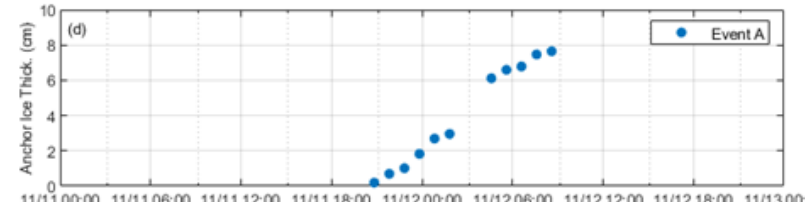
Figure 5. Time series of results during deployment DEP-1 showing (a) air temperature and incoming solar radiation, (b) water depth at the Water Survey of Canada (WSC) gauge #05DF001, (c) water temperature on the substrate, and (d) anchor ice thickness above the substrate for Event